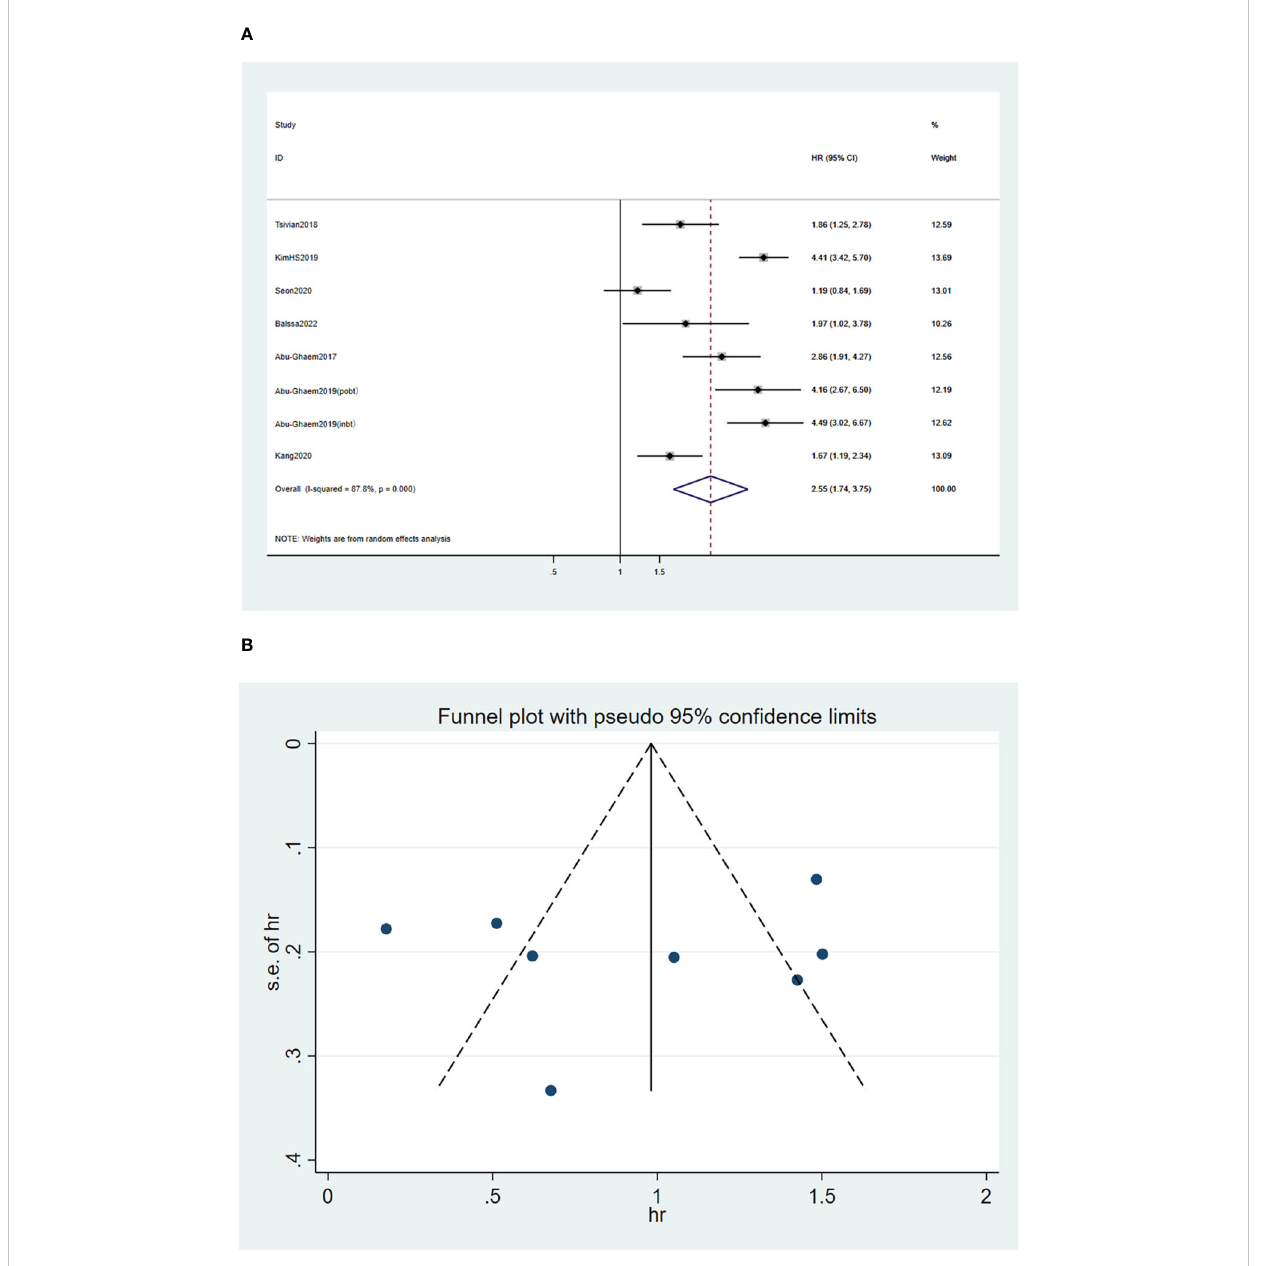
FIGURE 3 Forest plot (A) and funnel plot (B) depicting the association between PBT and recurrence-free survival. HR values greater than 1 indicate that the intervention is detrimental to survival, implying that PBT was associated with poorer